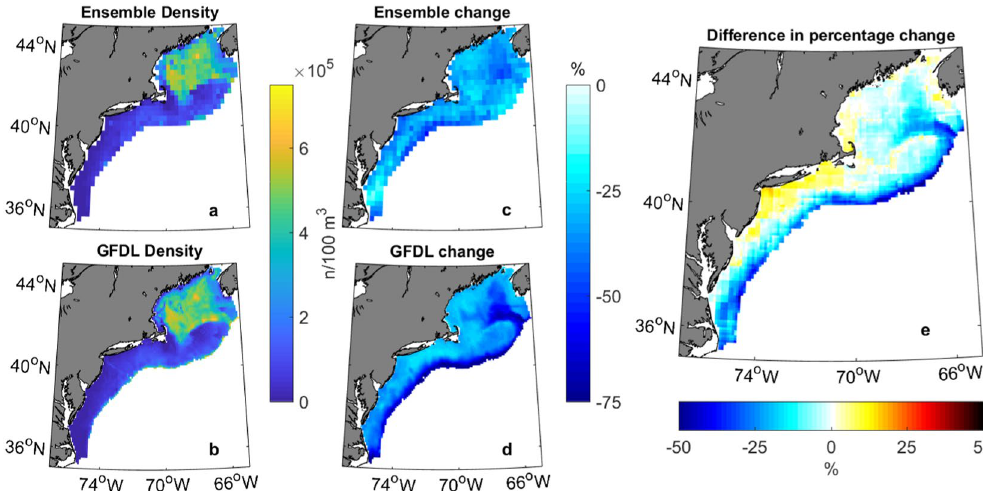
Figure 7. Comparison of the ensemble (0.25° RCP 8.5) and GFDL (.1° TCR). Time periods are twenty year annual averages for 1986–2005 of the historical ensemble scenario and 2041–2060 of RCP 8.5, compared to the same years 1–20 and 61–80 of GFDL CM 2.6 TCR scenario. ( a ) Early density of ensemble RCP 8.5 and ( b ) GFDL CM 2.6 TCR. ( c ) The percentage change between the late and early time periods of ensemble RCP 8.5 and ( d ) GFDL CM2.6 TCR. ( e ) The difference in the percentage change in density projected by each model (7d-7c). Warm colors indicate that the ensemble projects greater losses than GFDL in those regions. Correlation between the differences projected by the ensemble and GFDL CM 2.6 is 0.51. Figure was created by the first author in MATLAB v2015b (https://www.mathworks.com/products/matlab.html) using the package ‘M_Map’ v1.4 h